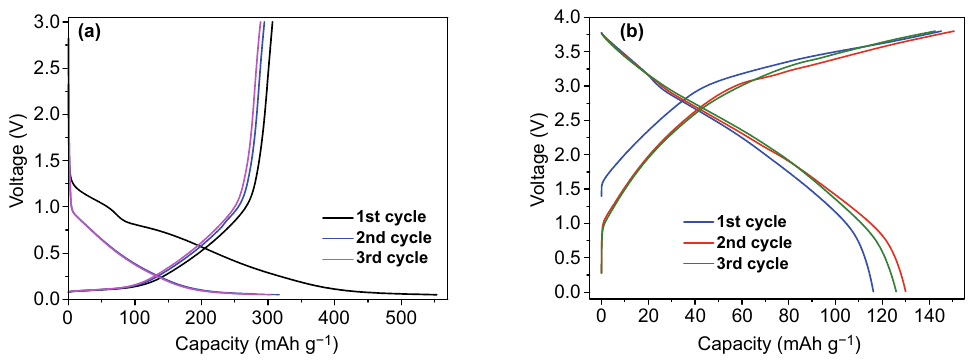
Fig. 10 Initial charge–discharge curves of a Na/NaPF 6 /HC half-cell in a voltage range of 0.01–3.0 V, and b HC/NaPF 6 /CuDEPP full cell in a voltage range of 3.8–0.01 V at a current density of 100 mA g −1 , where HC and the CuDEPP were used as an anode and a cathode, respectively. HC denotes hard